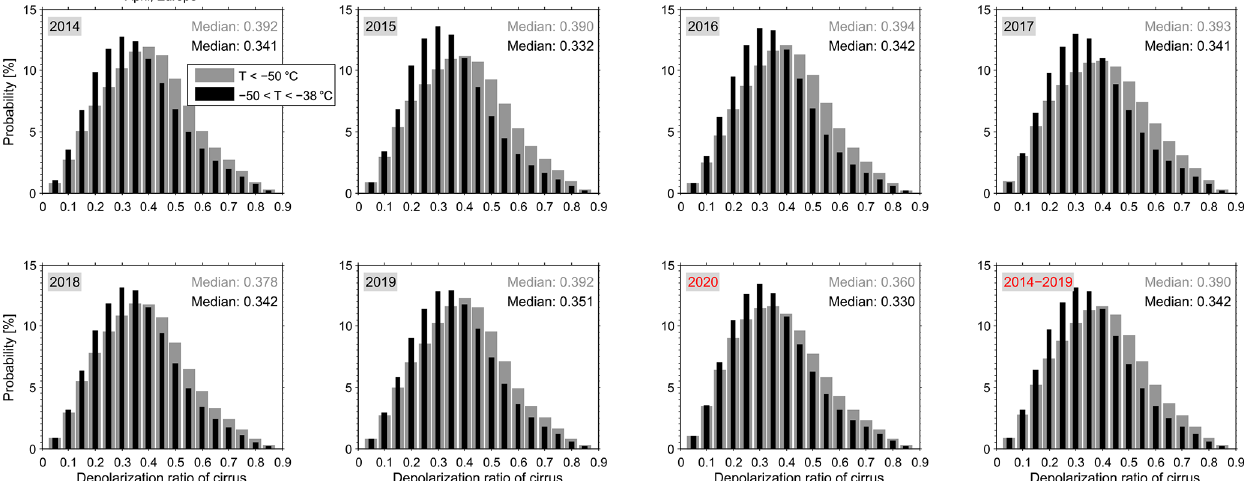
Figure 8. Distributions of the PLDR of cirrus clouds detected at temperatures from − 50 to − 38 ◦ C (black) and at temperatures colder than − 50 ◦ C (gray). The corresponding medians for each case are indicated in the plot.